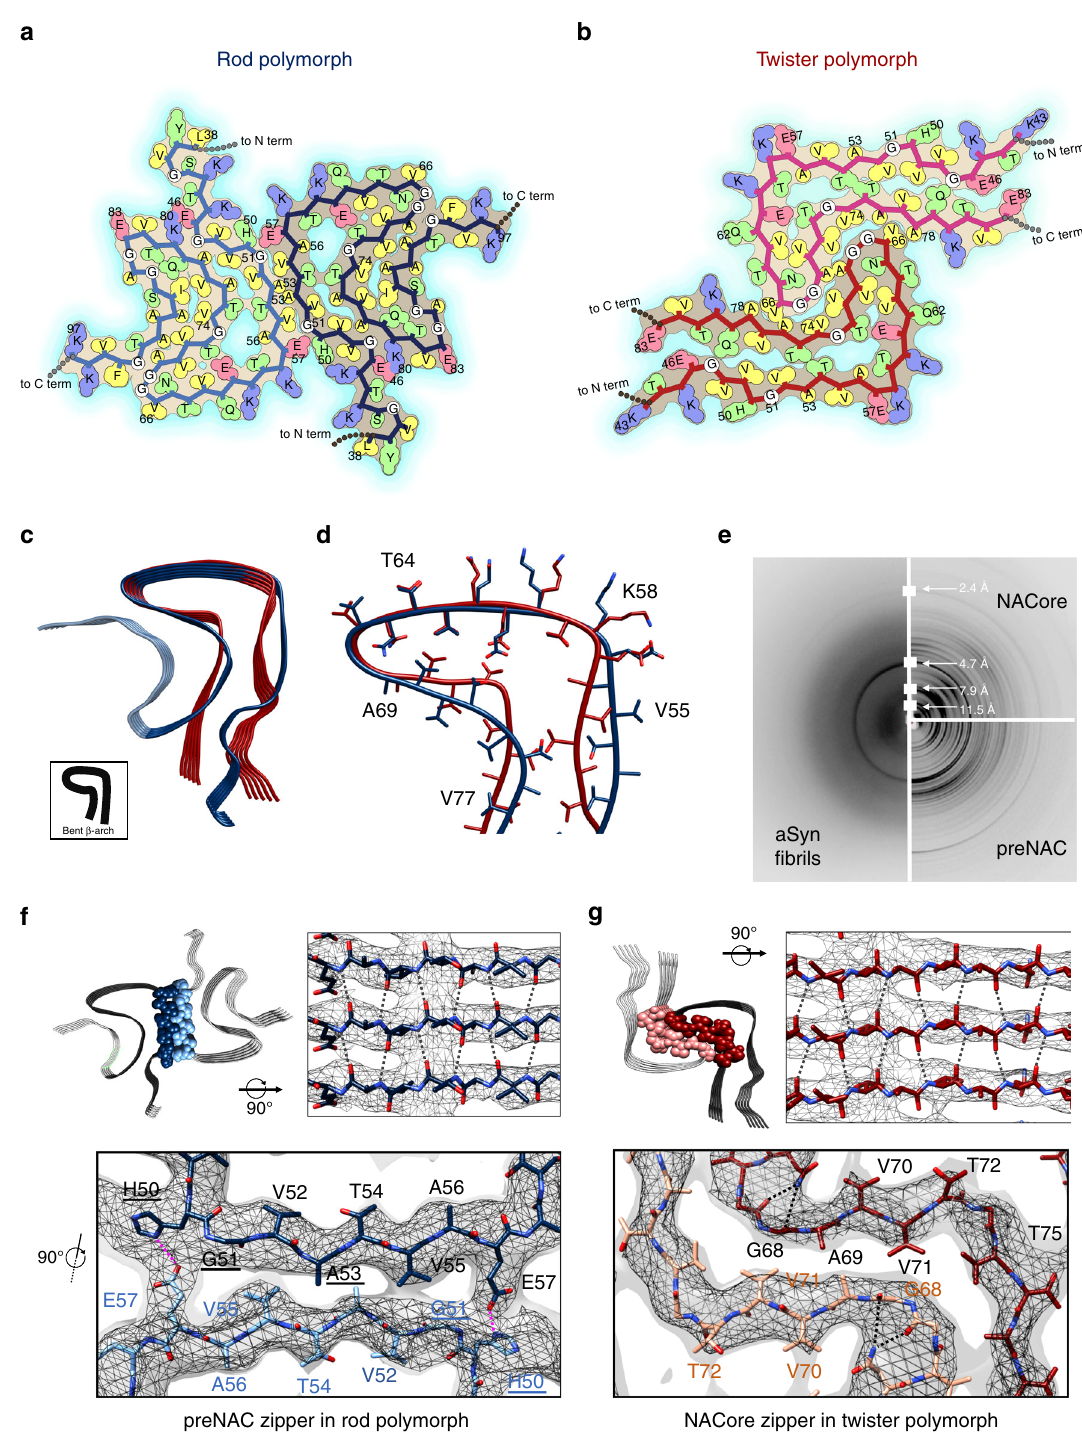
Fig. 3 Distinct zipper interfaces between proto fi lament kernels in the two aSyn polymorphs. a , b Residue interactions of two asymmetric units in two opposing proto fi laments elucidate packing between and within these two proto fi laments in the rod ( a ) and twister ( b ) polymorphs (viewed down fi bril axis). Residues are colored by hydrophobicity (yellow: hydrophobic; green: polar; red: negative charge; blue: positive charge). c , d An overlay of proto fi laments of the rod (blue) and twister (red) polymorphs reveals a conserved kernel of a bent β -arch. e Diffraction patterns of the full-length aSyn fi brils agree with those of NACore and preNAC peptide fi brils. f , g The two proto fi laments in the rod ( f ) and twister ( g ) polymorphs contact by different residues (space- fi lled) and have distinct fi bril core of tightly packed steric zippers of preNAC (blue) and NACore (red), as previously observed in those peptide fi bril structures. PD familial mutation residues are labeled with underlines. The cryo-EM density maps are shown as gray mesh surfaces. Intra-proto fi lament hydrogen bonds are shown in black dashed lines, and inter-proto fi lament hydrogen bonds are in